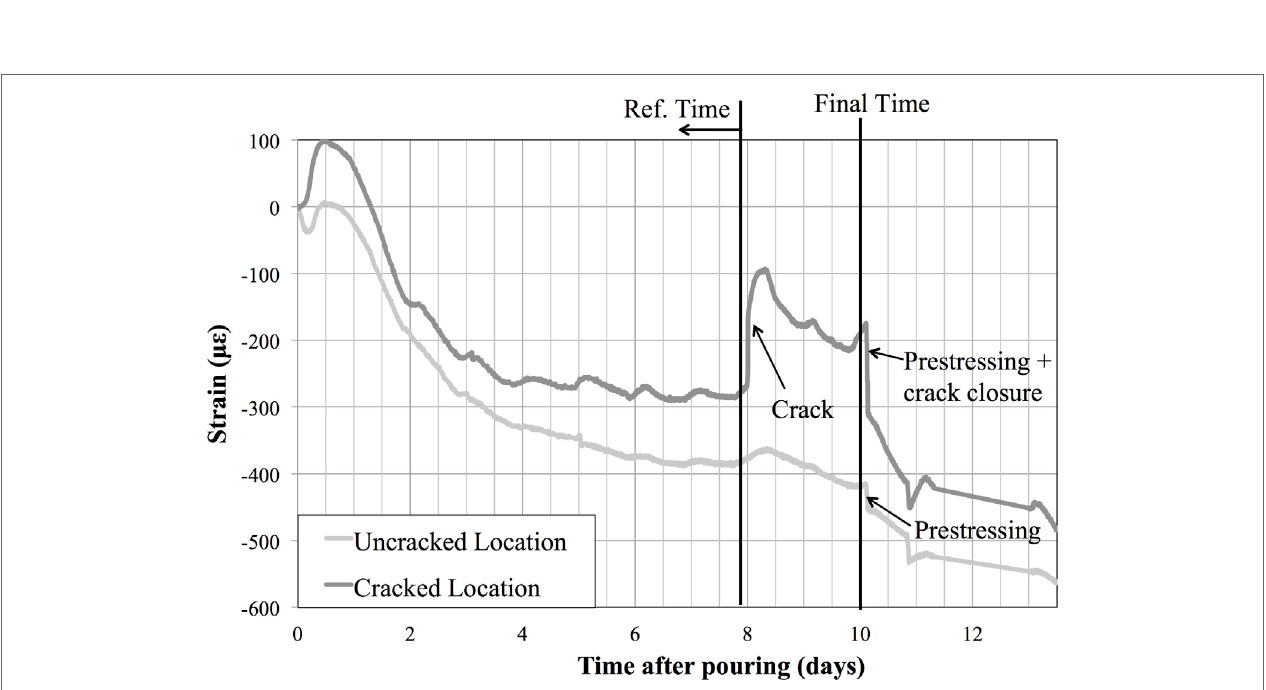
FIGURe 3 | example of a time history of strain measurements for healthy (uncracked) and cracked locations showing the occurrence of a crack